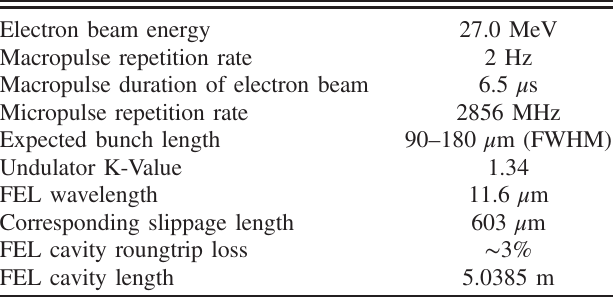
TABLE I. The operation parameters of the KU-FEL during the